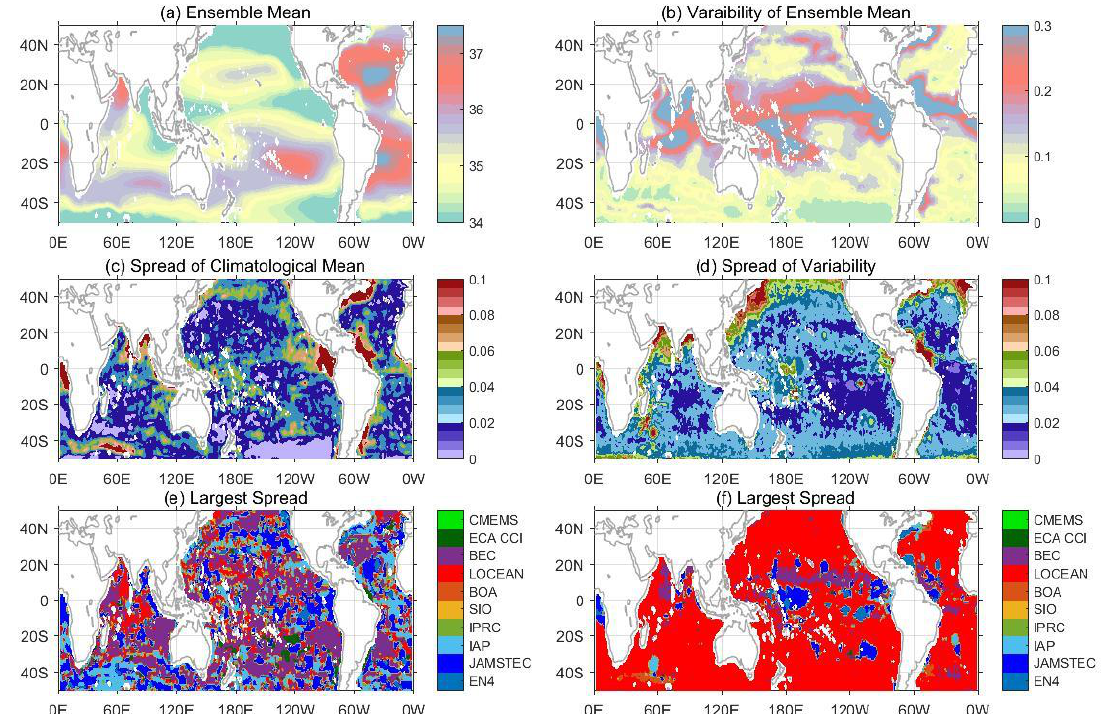
Figure 1. The horizontal distribution of ( a ) the ensemble mean ( S ), ( c ) STD ( S STD ), and ( e ) largest spread of the climatological SSS derived from ten products averaged over 2011–2018. ( b ), ( d ) and ( f ) are the same as ( a ), ( c ), and ( e ) but for the variability in SSS estimated by STD over 2011–2018. Blank regions denote that no existing data were available for at least one product.